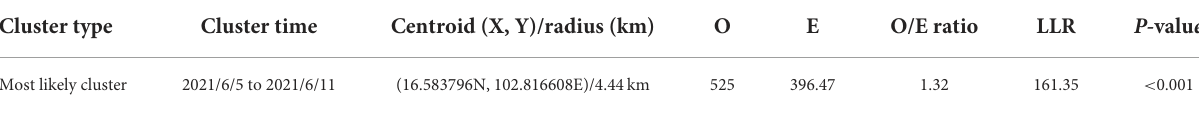
TABLE 3 Spatio-temporal analysis of lumpy skin disease outbreaks in dairy farms, Khon Kean province, Thailand by Bernoulli model.